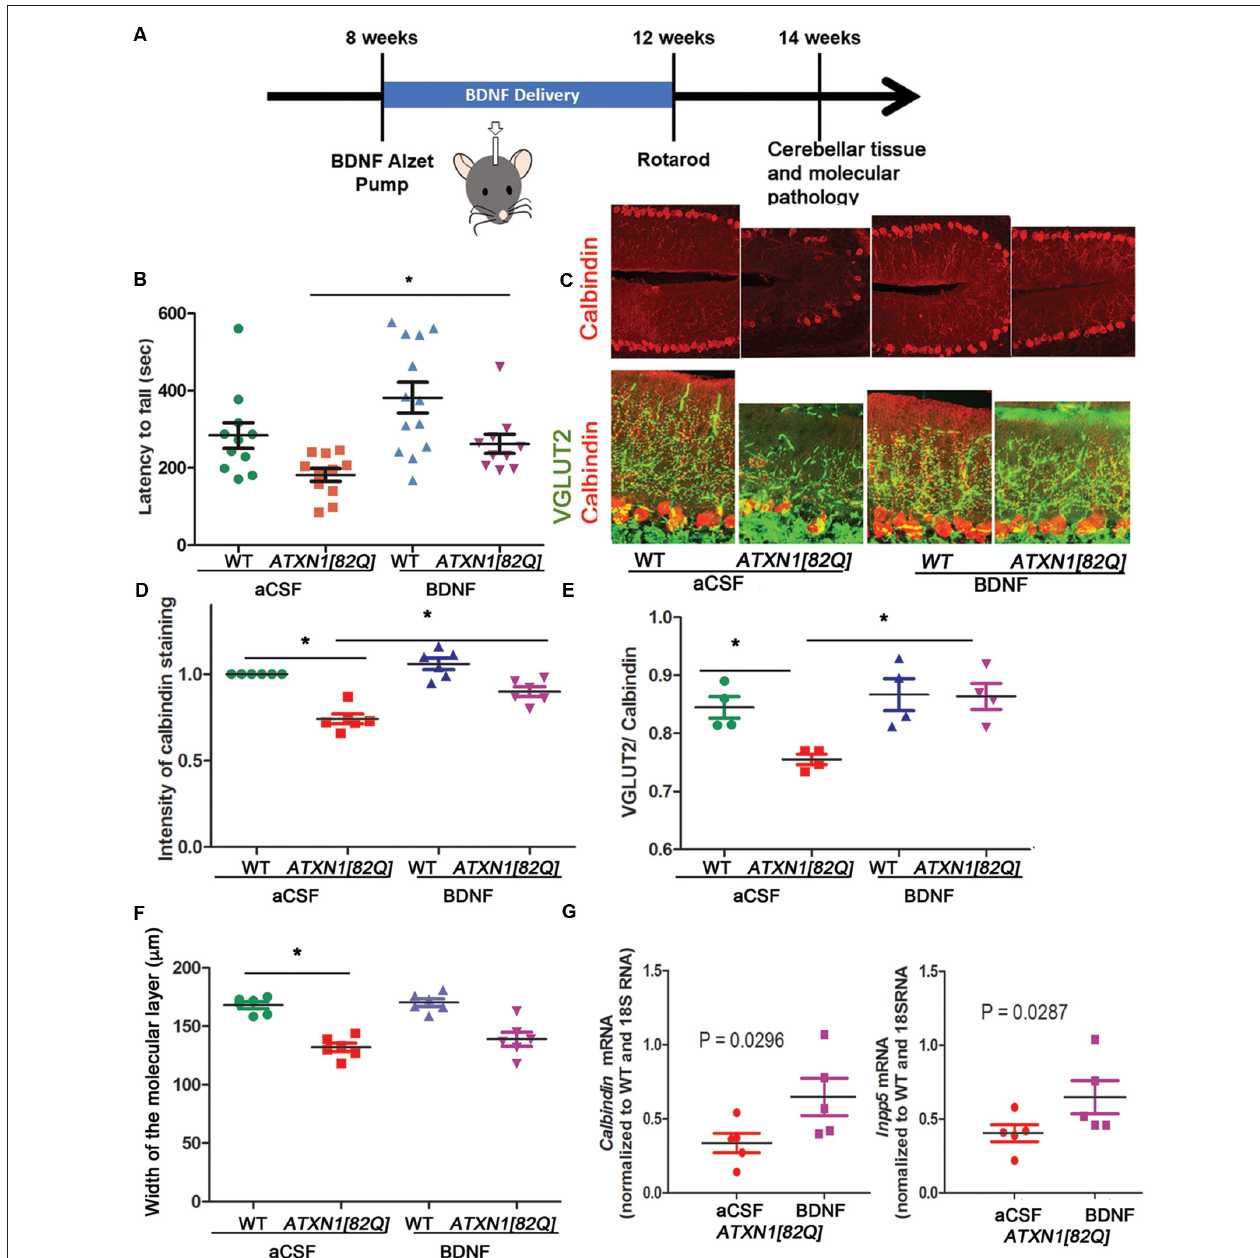
FIGURE 2 | BDNF delivery delays disease pathogenesis in ATXN1[82Q] mice. (A) Experimental scheme to test the role of BDNF early in SCA1. (B) Rotarod performance of mice at 12 weeks. ∗ P < 0.05 using one-way ANOVA with Kruskal-Wallis test. (C–F) Cerebellar slices from 14-week-old mice were stained with antibody specific for Purkinje neuron-marker calbindin and vesicular glutamate transporter 2 (VGLUT2) to label climbing fiber synapses on Purkinje neurons. ImageJ was used to quantify (D) calbindin intensity in the Purkinje neurons, (E) length of climbing fiber synapses (VGLUT2 puncta) on Purkinje neuron dendrites (determined as VGLUT2/calbindin ratio), and (F) width of the molecular layer. ∗ P < 0.05 using one-way ANOVA with Bonferroni’s multiple comparison test. (G) RT-qPCR analysis of disease associated Purkinje neurons genes calbindin (left) and Inpp5 (right). Student’s t -test P values. For all error bars = SEM. Each dot represents a biological